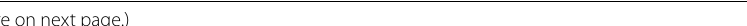
(See figure on next page.) Fig. 9 Rock avalanche deposit at outcrop. A Dark gray brecciated limestone near the base of the Flims rock avalanche deposit at the locality Islaplanggen (coord. 2744250/118350). The photograph taken in winter shows icicles emanating from several point sources within the black limestone. Light colored scree outcrops in steep narrow gullies. B) Detailed view of dark gray brecciated limestone at the confluence of Rabiusa and Vorderrhein (coord. 2744350/1185350). A ca. 10 cm thick breccia layer (double arrows) with centimeter scale components in a fine-grained comminuted white limestone matrix cuts across highly fractured limestone (Quinten Limestone). Fracturing and comminution are also responsible for the occurrence of small pockets of comminuted white limestone within the fractured limestone. All in all the rock fabric is indicative for a cataclasite. C Gray fractured limestone cataclasite in the cliff 400 m WSW of the railroad station Versam-Safien (coord. 2742550/1185500). The photograph on the left shows a “block-in-powder” texture with angular blocks in a comminuted limestone matrix. The photograph on the right shows a vertical fault with a white fault gouge (double arrows) consisting of comminuted limestone. Photos A. Pfiffner. D Large fragmented compartments in the lower reaches of the Versamertobel (coord. 2745330/1185240). A large compartment with original bedding (arrows) is visible below the road and a large compartment with folds above the road. A sharp contact separates the latter on the left from a cataclasite (cc) with “block-in-powder” texture. Photo courtesy M.